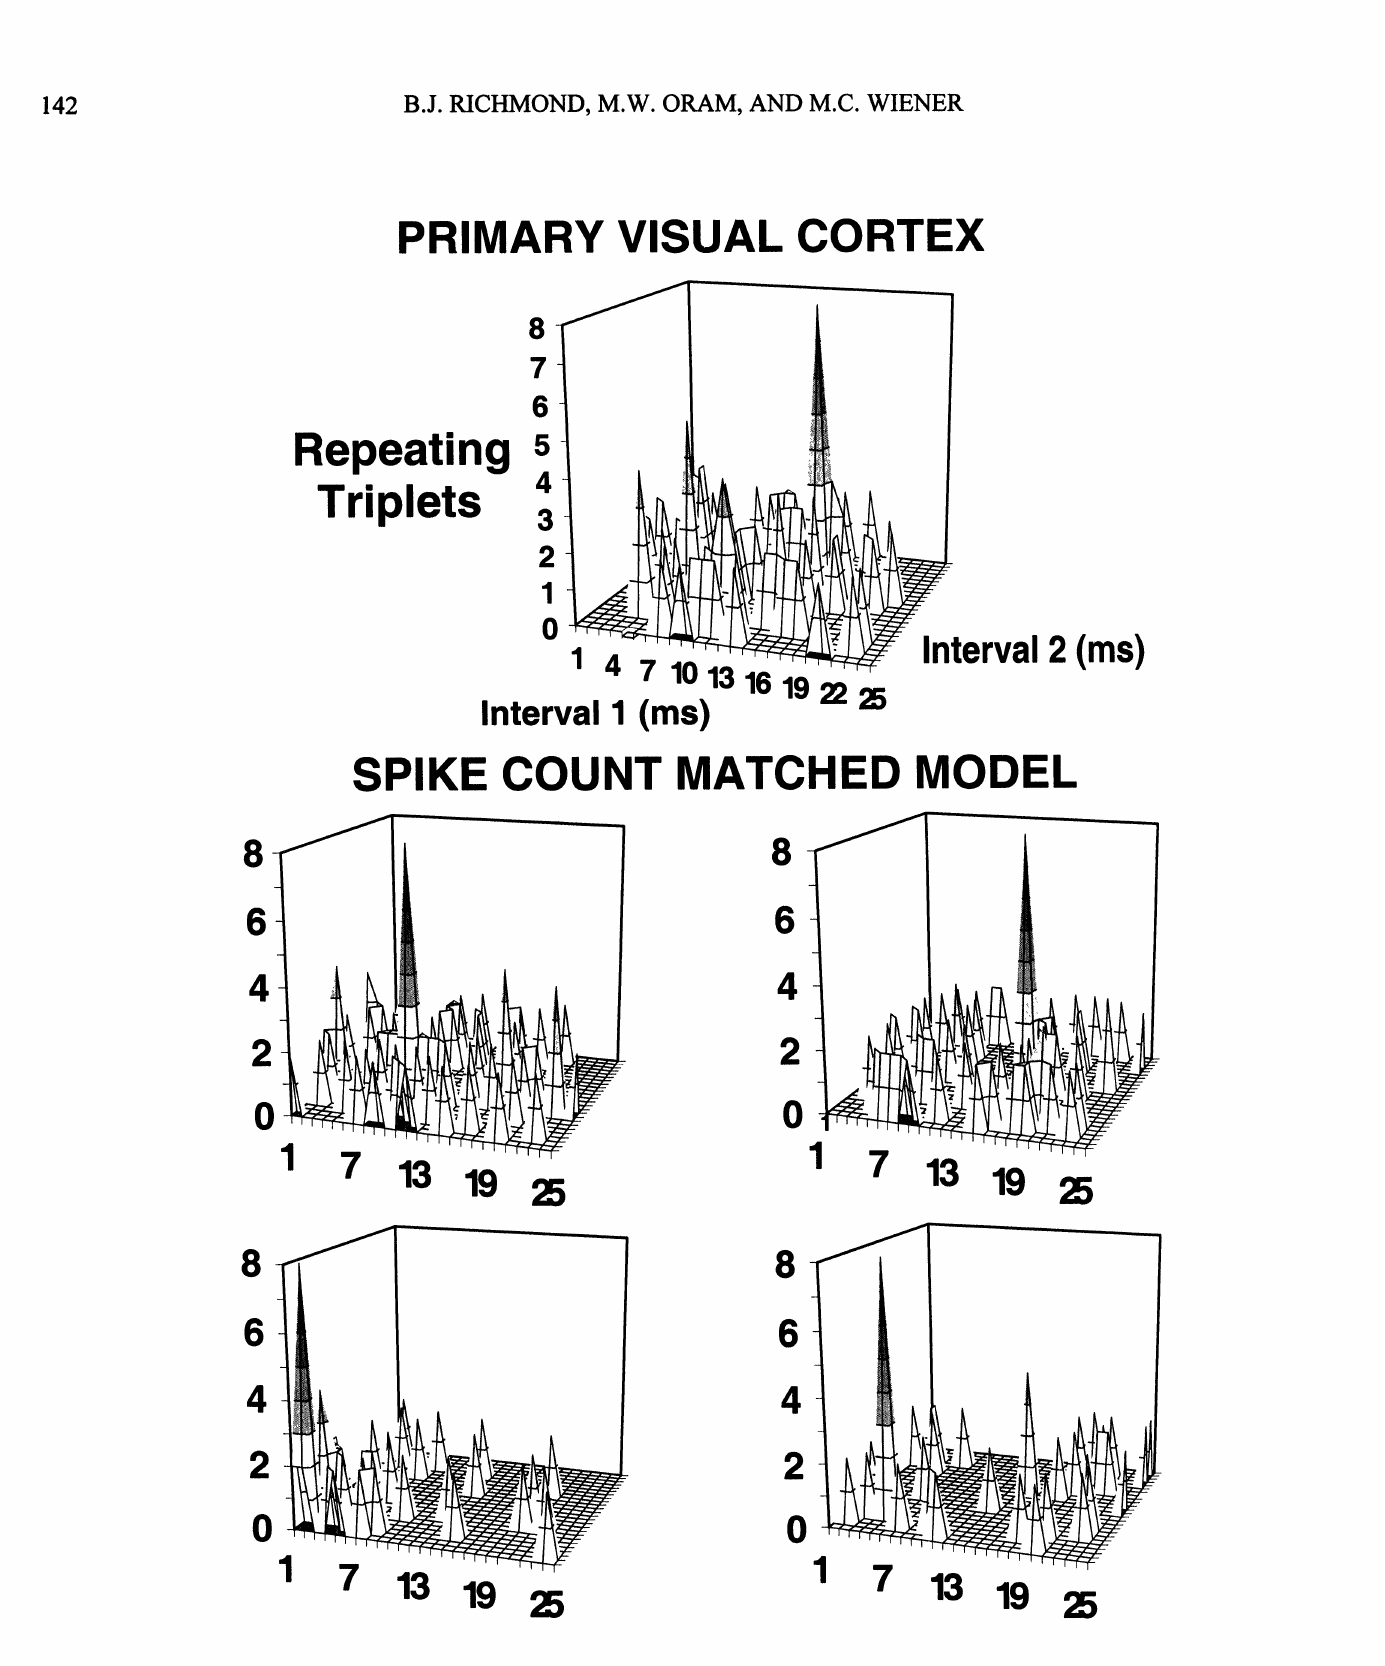
Fig. 6: Numbers of repeating triplets of all types with each interval less than or equal to 25 ms. The top panel shows the numbers, of repeating triplets of each type for one stimulus in a V complex cell. The other 4 panels show 4 different simulation runs. These figures indicate the difficulty with multiple comparisons. Although the triplets occurred most otten are different in the data and simulations, they are different across the different simulations, indicating that the numbers ofeach triplet type, including the ones occurring most frequently, can arise from a stochastic